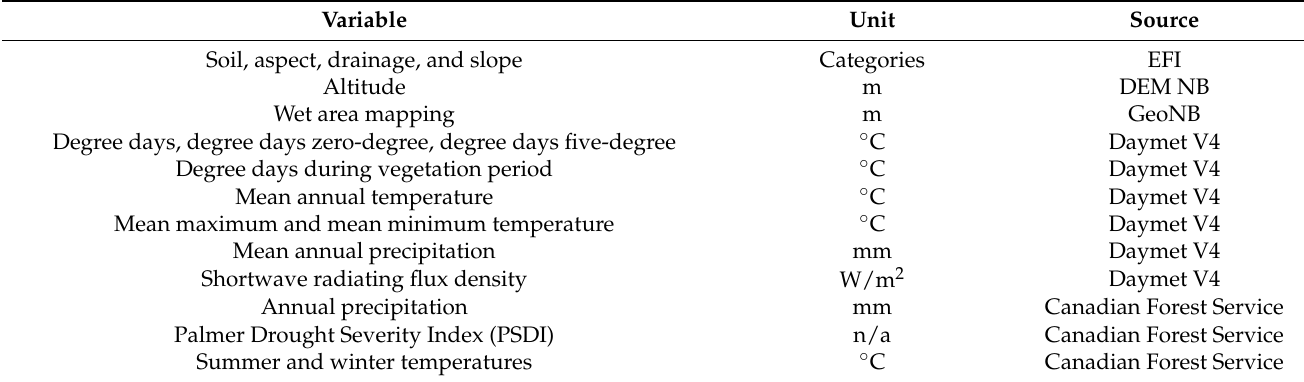
Table 4. Environmental variables used for analysis.